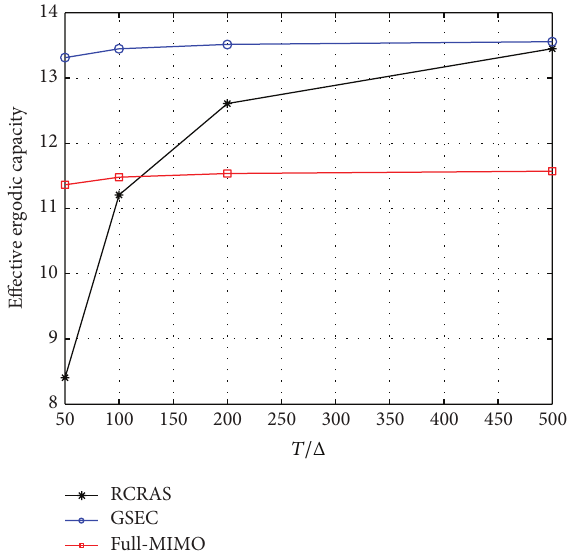
Figure 11: Effective ergodic capacity VS. 𝑇 ( 𝜌 = 20 dB) ( 𝑁 𝑇 = 4 , = 20 , 𝐿 = 4 , 𝐷 = 𝐷 = 𝜆 𝑁 𝑅 𝑅 𝑇 𝑅